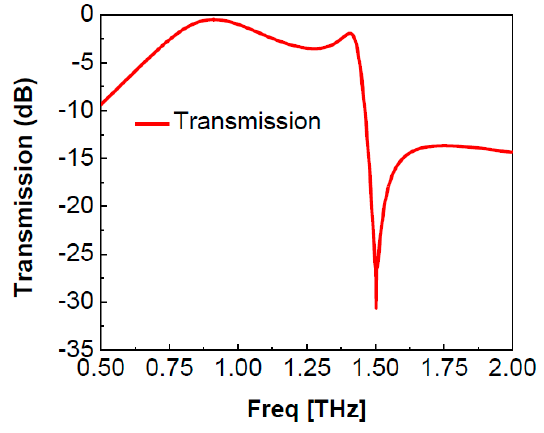
Figure 11. Transmission characteristics of the receive filter.